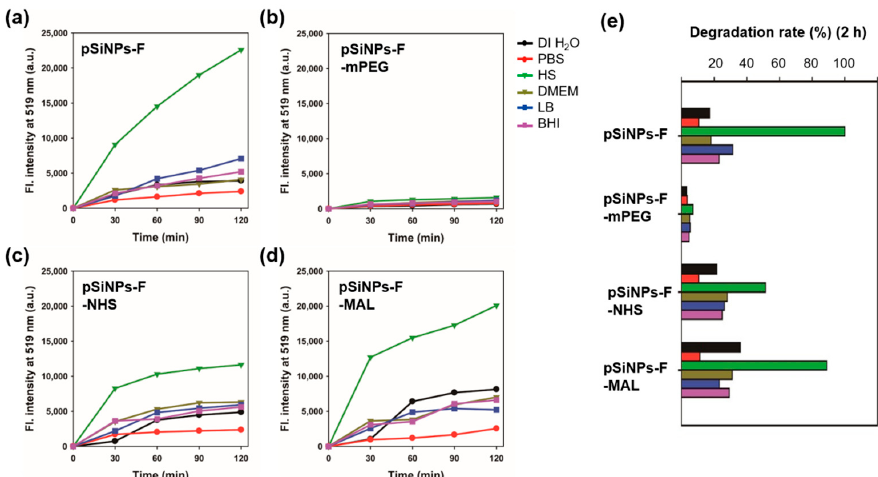
Figure 6. ( a – d ) Time-dependent fluorescence intensity (at 519 nm) plot of supernatant for the pSiNPs samples (100 μ g/mL) in different biological solutions incubated at 37 ° C for 0–120 min; black = DI H 2 O, red = PBS, olive = HS, khaki = DMEM, blue = LB, and purple = BHI. The supernatant was collected at the given time point (30 min intervals) using centrifugation (14,000 rpm, 15 min) of the pSiNPs-containing solution. The fluorescence intensity was corrected based on the fluorescence intensity of Silane-PEG-FITC in each solution (Figures S1 and S2 in Supporting Information). The fluorescence intensity was recorded after excitation at 495 nm at room temperature (25 ° C). ( e ) Degradation rate (%) plot of the pSiNPs samples under given conditions. Table 2. Calculated half-degradation time-points for the pSiNPs samples. 1 Unit: min.